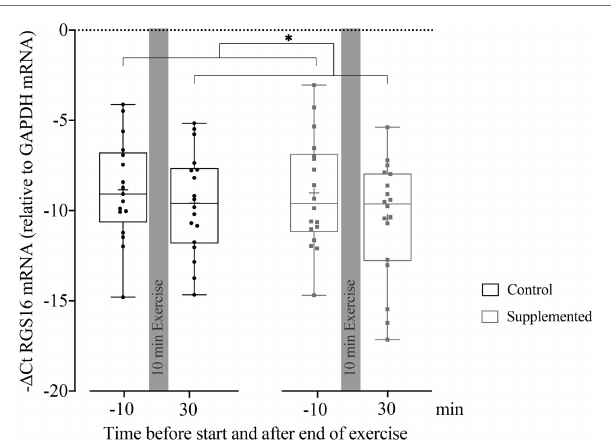
FIGURE 3 | Relative quantification of RGS16 mRNA to GAPDH mRNA in MNCs using the Δ Ct method ( n = 17 for control intervention and n = 18 for supplemented intervention). Bars include 50% of all data points while the line within the bars represents the median. Additionally, the mean is indicated by a “+”-sign in each bar. Whiskers represent minimum and maximum values with all individual data points being shown. Differences between the two time points are indicated by *, with * p <